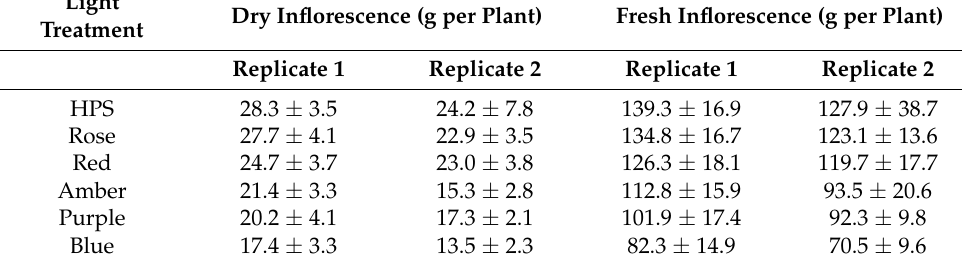
Table 2. Effect of light treatment on average fresh and dry inflorescence per replicate. Treatments are high-pressure sodium (HPS), Blue (430 nm), Red (630 nm), Rose (430 + 630 nm, ratio B:R 1:10), Purple (430 + 630 nm, B:R ratio 2:1), and Amber (595 nm). The results are mean and SE ( n = 9). Light Dry Inflorescence (g per Plant) Fresh Inflorescence (g per Plant) Treatment Replicate 1 Replicate 2 Replicate 1